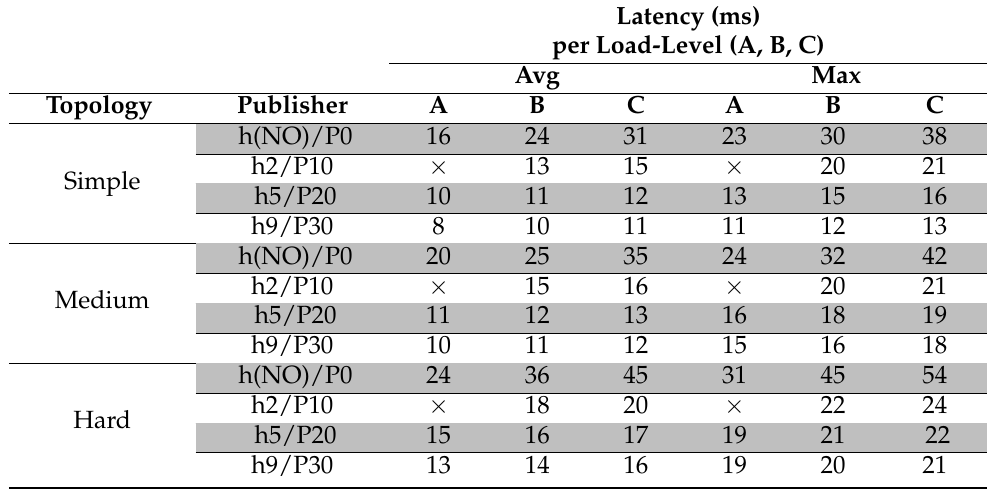
Table 3. Average/Maximum latency of TS and NO MQTT flows with real-time extensions.